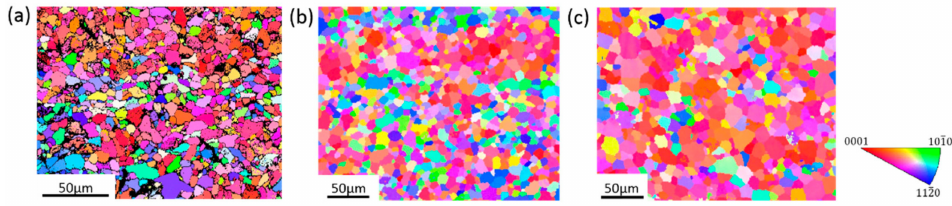
Figure 6. Inverse pole figure (IPF) maps of annealed Mg wires. ( a ) 200 ◦ C / 5 min; ( b ) 300 ◦ C / 30 min; ( c ) 350 ◦ C / 120